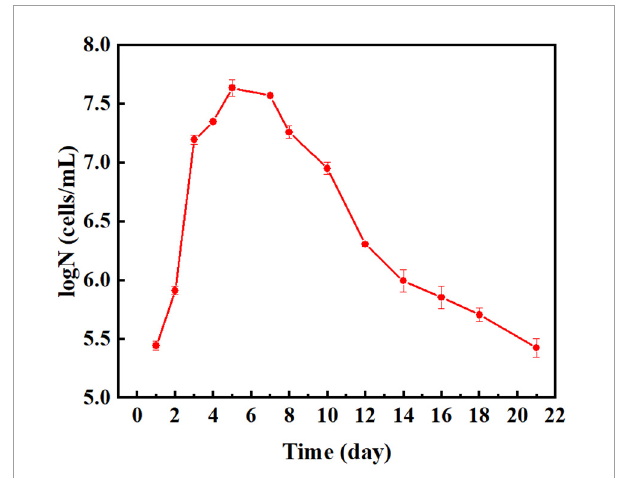
FIGURE1 Planktonic cell counts of P. aeruginosa at 21 days of